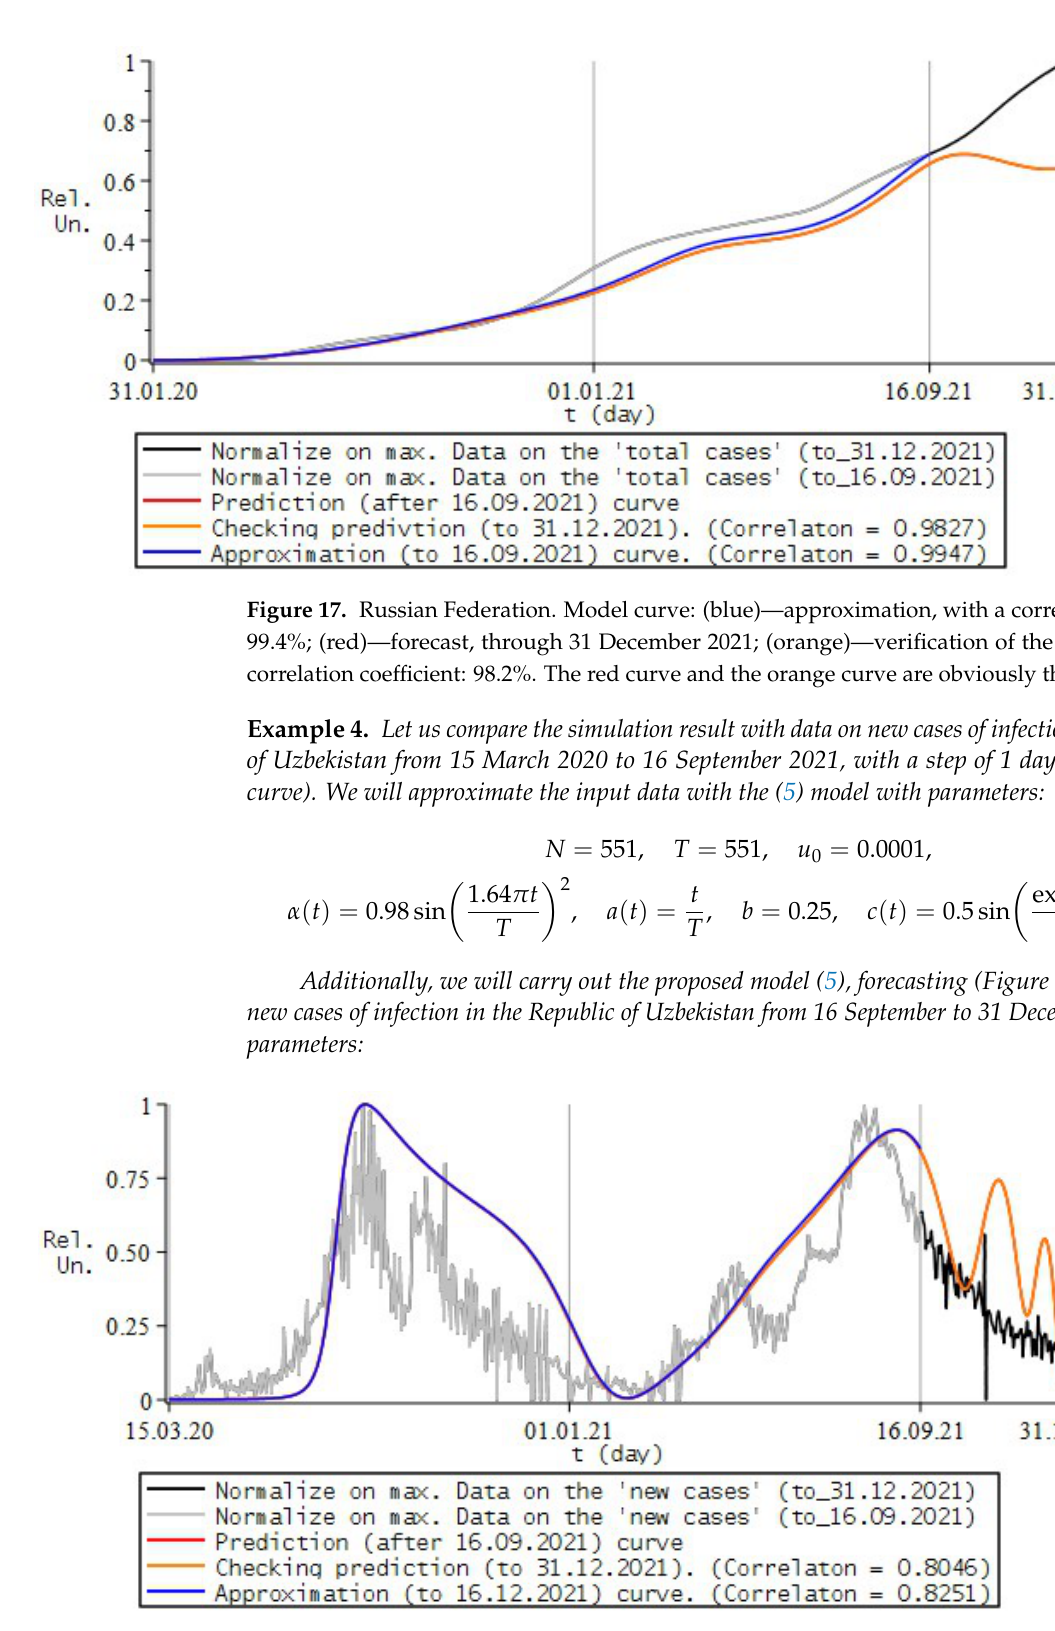
Figure 18. The Republic of Uzbekistan. Model curve: (blue)—approximation, with a correlation coefficient: 82.5%; (red)—forecast, through 31 December 2021; (orange)—verification of the forecast with the correlation coefficient: 80.4%. The red curve and the orange curve are obviously the